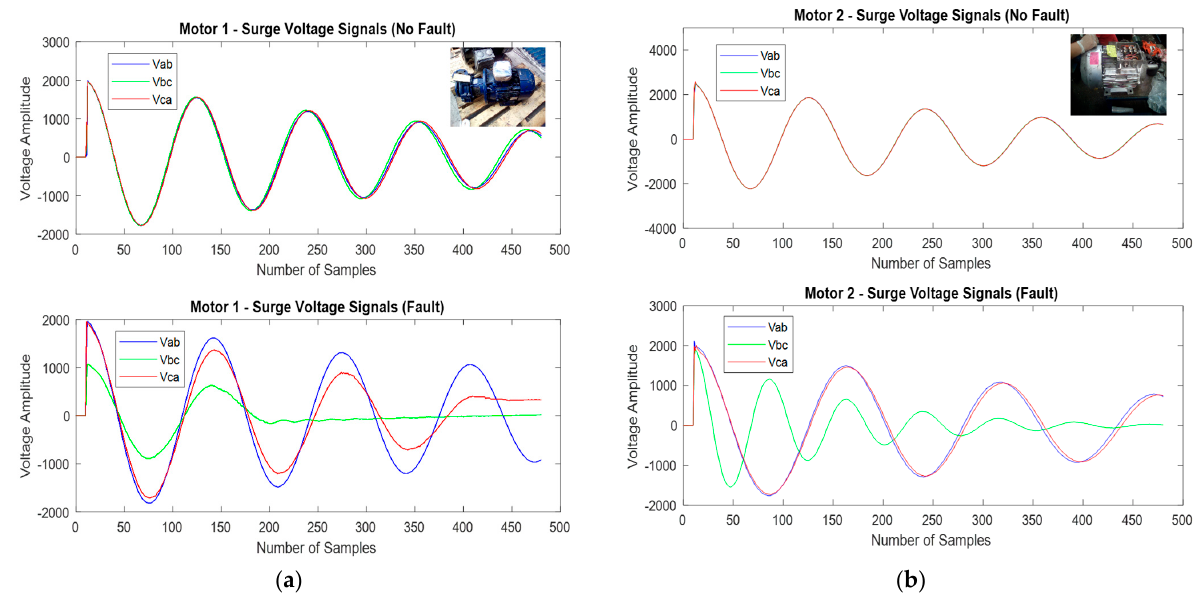
Figure 7. Tested motors and resulting surge waveforms from SCT ( a ) Motor 1 ( b ) Motor 2.